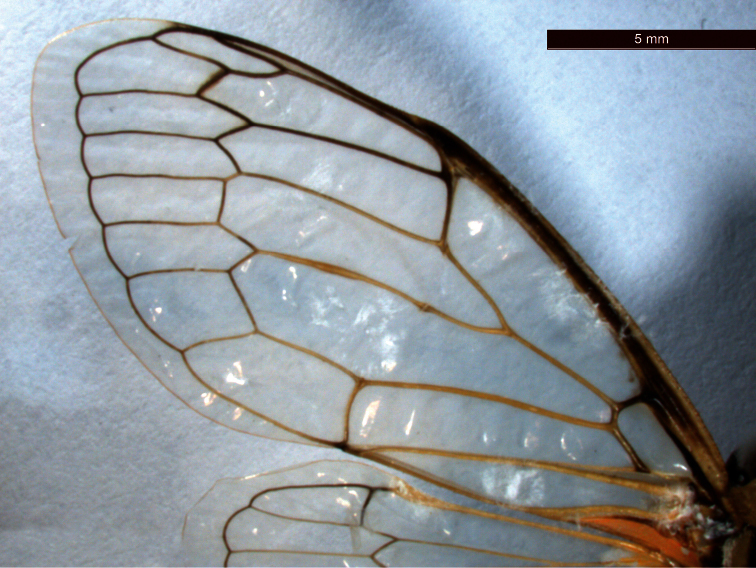
Cicadatra platyptera, front fore wing (scale= 2.6 mm).